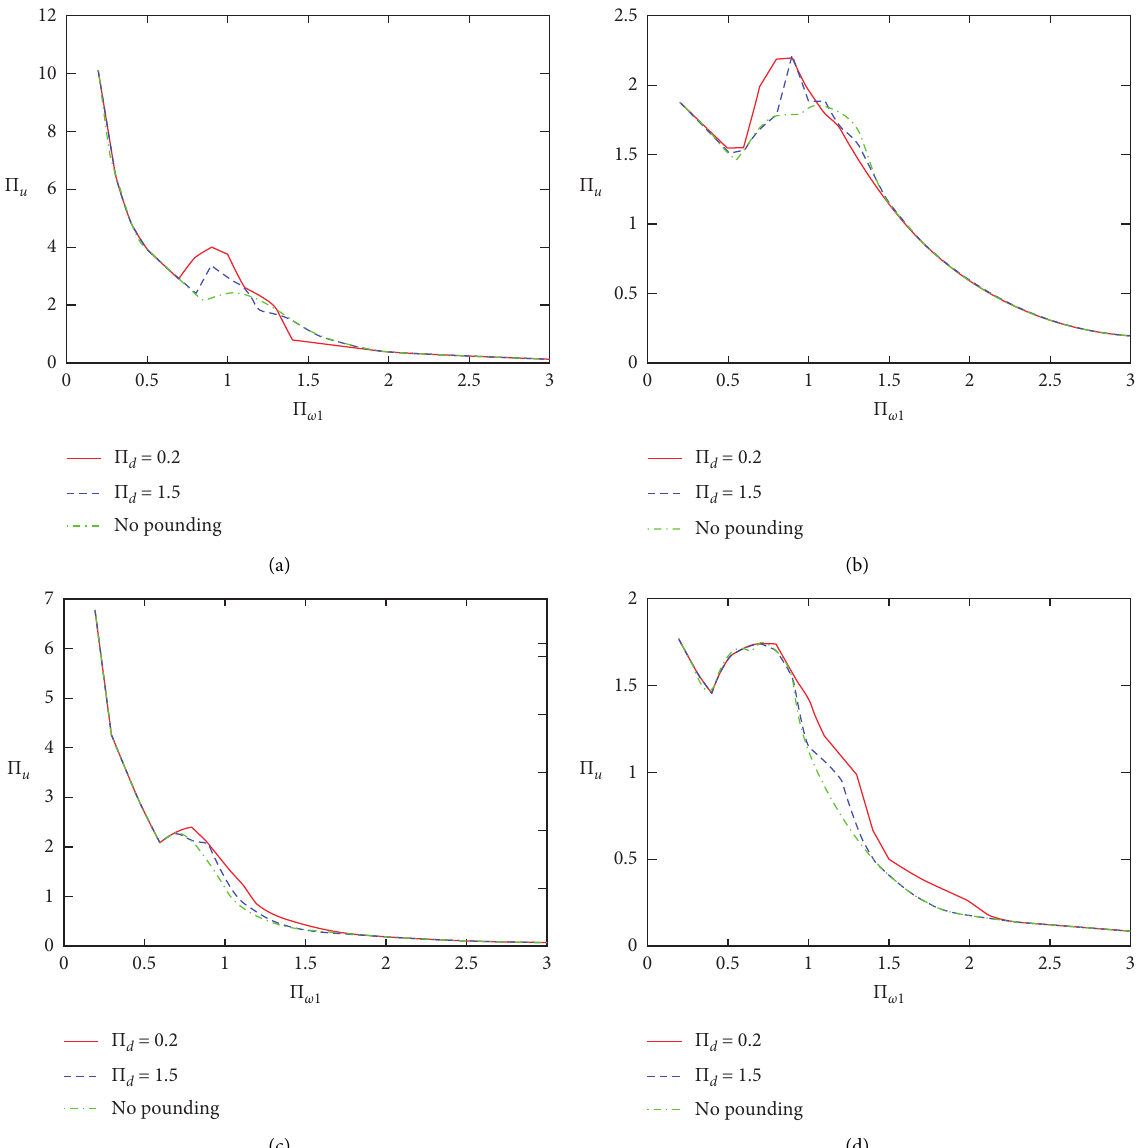
Figure 10: Maximum dimensionless displacement Π u and velocity Π v versus Π ω 1 for various frequency ratios μ ( Π m � 0 . 9, Π � 0 . 8, Π � 0 . 9, Π � 0 . 1, Π � 50, Π � 0 . 4, and Π � 0 . 2). (a) Maximum dimensionless displacement Π Π uy uy 2 uy 1 r d 1 α ω con structure. (b) Maximum dimensionless velocity Π v of left-side structure. (c) Maximum dimensionless displacement Π u of right-side structure. (d) Maximum dimensionless velocity Π v of right-side